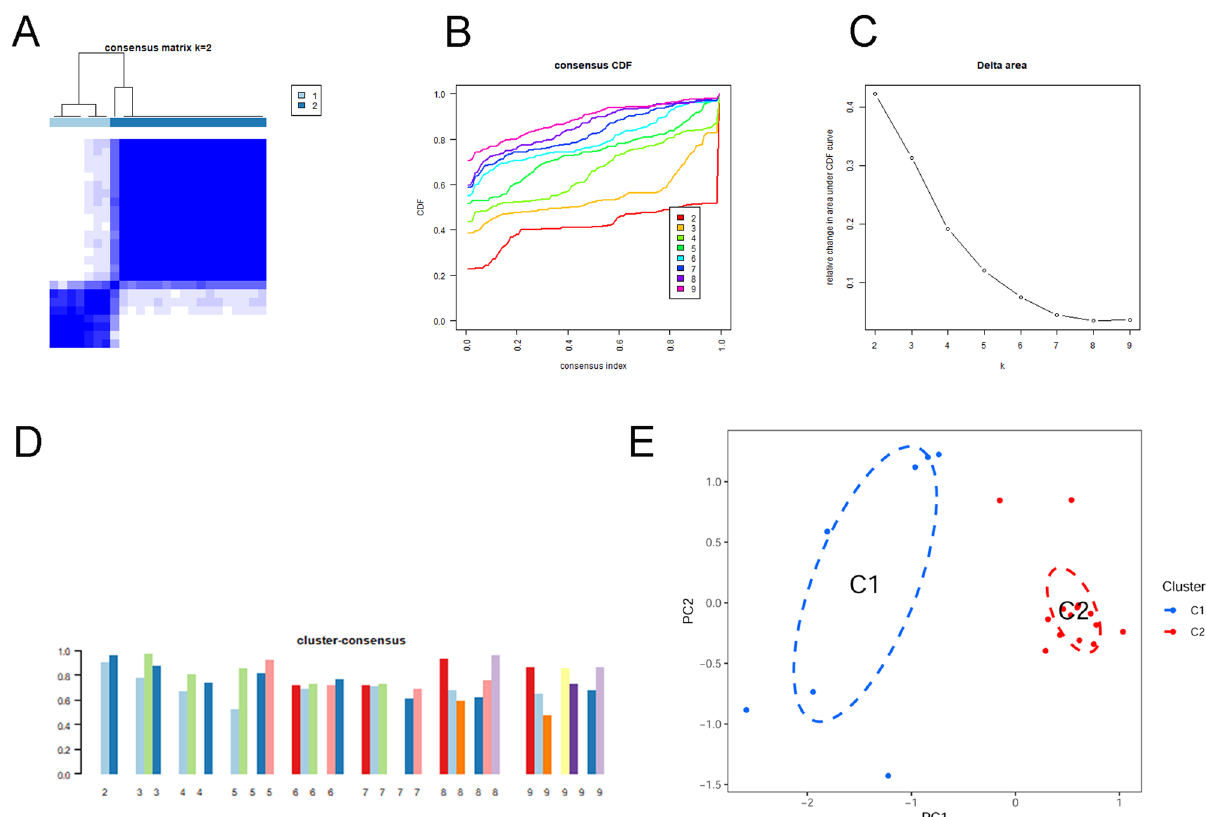
Figure 3. Identification of molecular clusters related to cuproptosis in PCOS. ( A ) Cluster-consensus matrix when k = 2. ( B ) Cumulative distribution function (CDF) curves. ( C ) CDF delta area curves. ( D ) The score of cluster-consensus. ( E ) PCA visualized the distribution of two